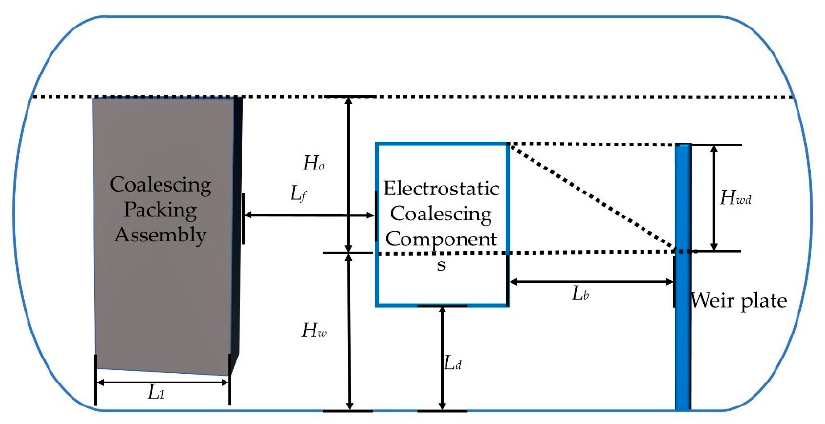
Figure 4. Schematic diagram of the installation position of each component inside the separator.